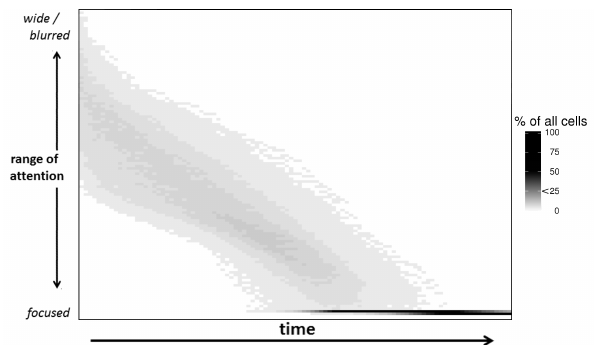
Figure 3: Shown is the frequency distribution of observed focus lev- els (y-axis, going from extreme wide focus , top, to highly focused , bottom) over time (x-axis). The results shown were obtained from simulating 100 × 100 cells arranged in a perfect hexagonal mash, each cell with 6 neighbours. Collectively, these cells processed 10 6 signals, ≈ 100 per cell. Due to the set-up of the simulation the best possible solution is known: complete coverage at optimal focus levels can be achieved with all cells operating at the same (highly focused) level. The allocation of signals to cells at start time is random and cells are initialised to a wide focus level. The system quickly and consistently settles into the optimal